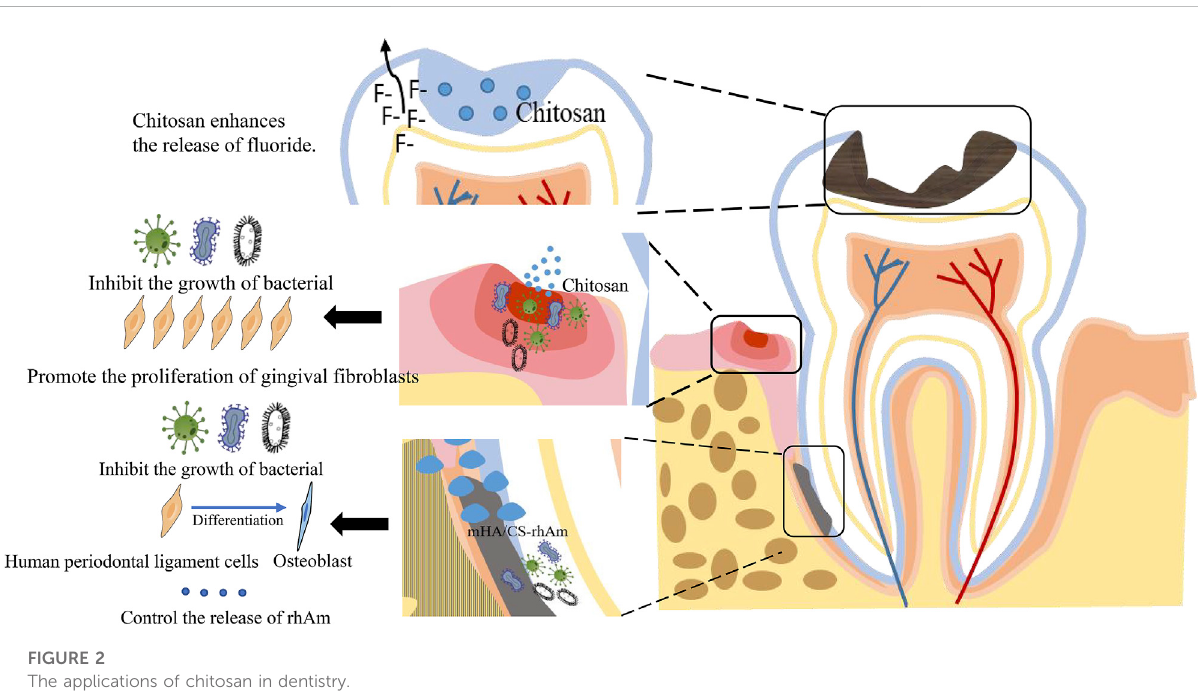
FIGURE 2 The applications of chitosan in